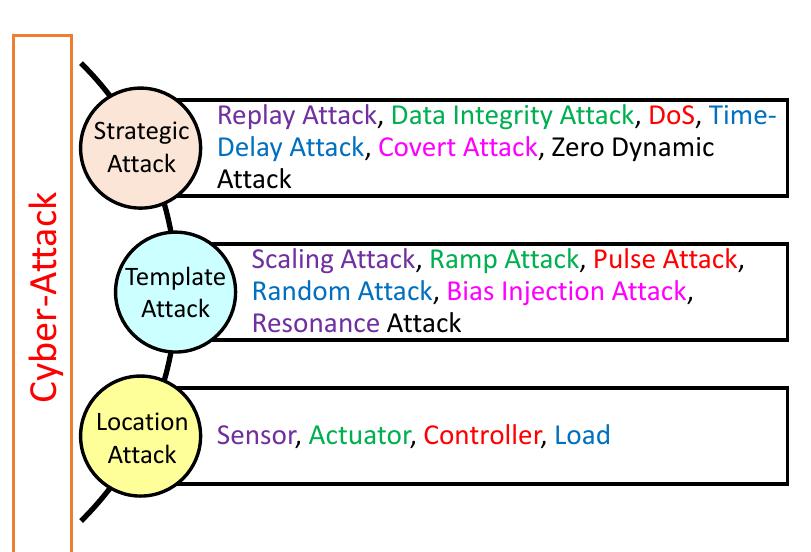
Figure 2. Classification of cyber-attacks on LFC.